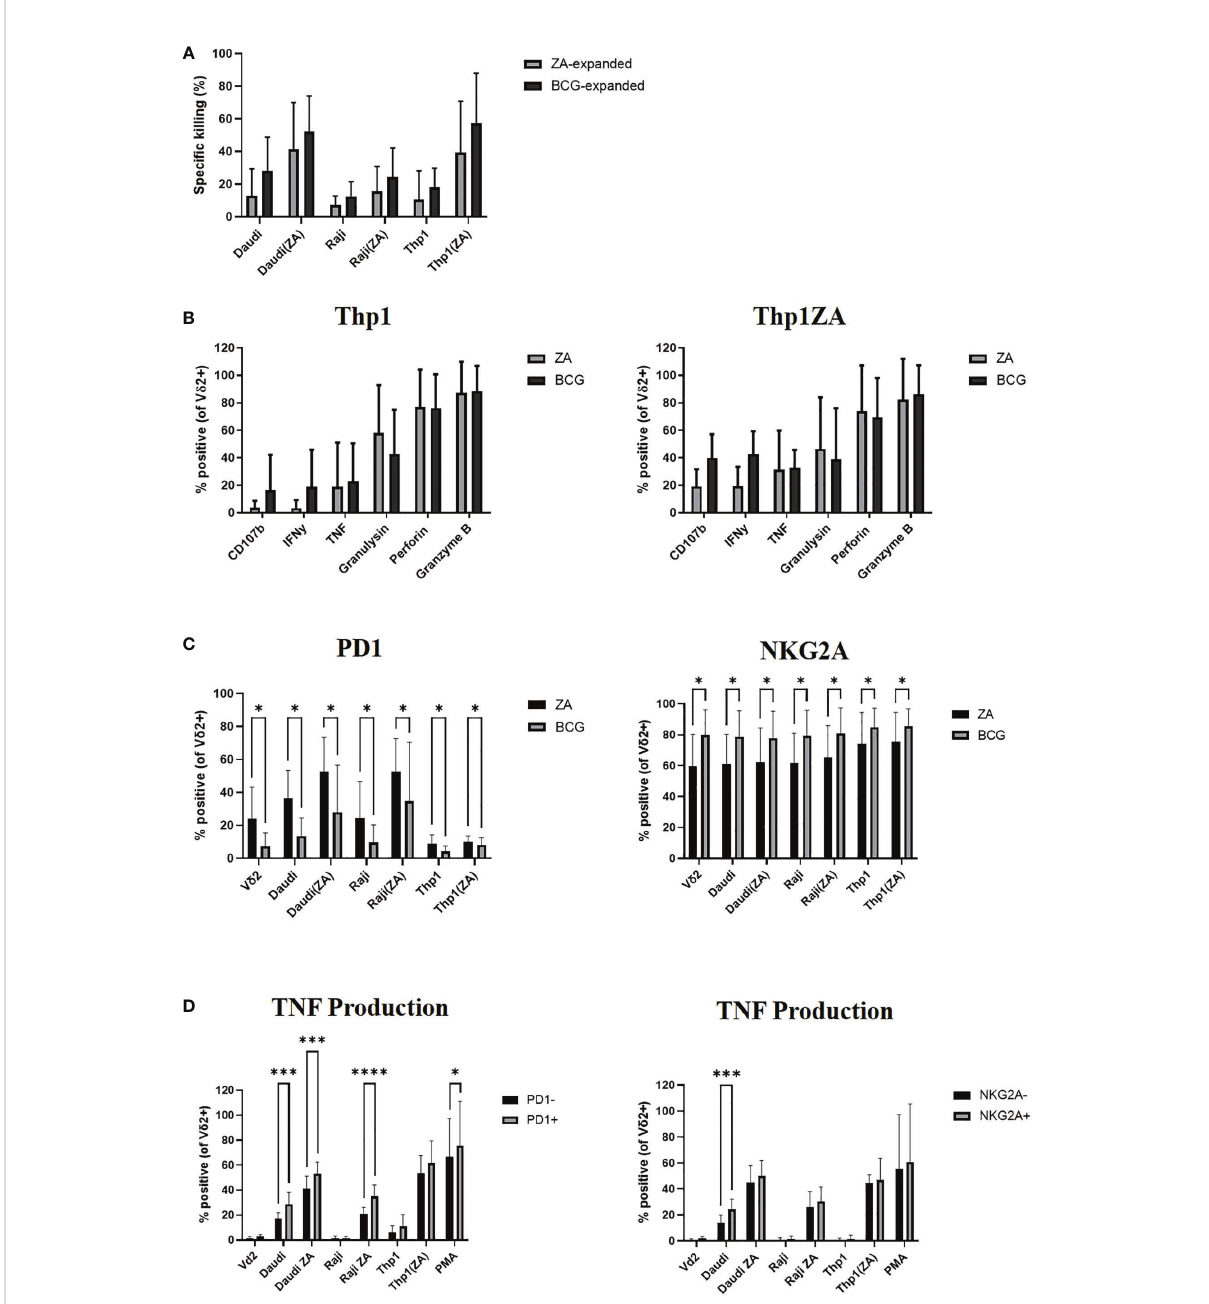
FIGURE 4 V d 2 cells, expanded with ZA or HK-BCG, were isolated and cultured with CTFR labelled Daudi, Raji or Thp1 cells, cultured with or without 50 m M ZA prior to culture with V d 2 cells, at a 1:1 ratio. Speci fi c killing of tumour cells was calculated after 16 hours co-culture (A) . After 4 hours co- culture the production of CD107b, IFN g , TNF, granulysin, perforin and granzyme B was assessed by fl ow cytometry (B) , expression of PD1 and NKG2A was assessed (C) and production of TNF was assessed on receptor positive and receptor negative cells (D) . N=6. *p<0.05, ***p<0.0005, ****p<0.0001, non-parametric analysis of variance with Tukey ’ s post hoc for multiple pairwise